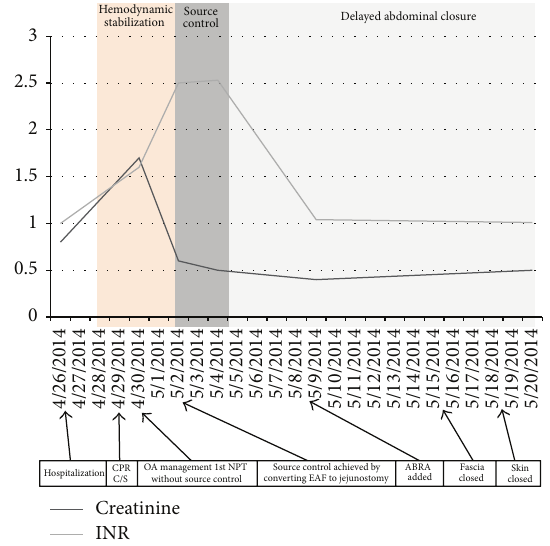
Figure 2: All the important interventions are given on the scale and change in the creatinine and INR level according to these interventions from hospitalization to closure of